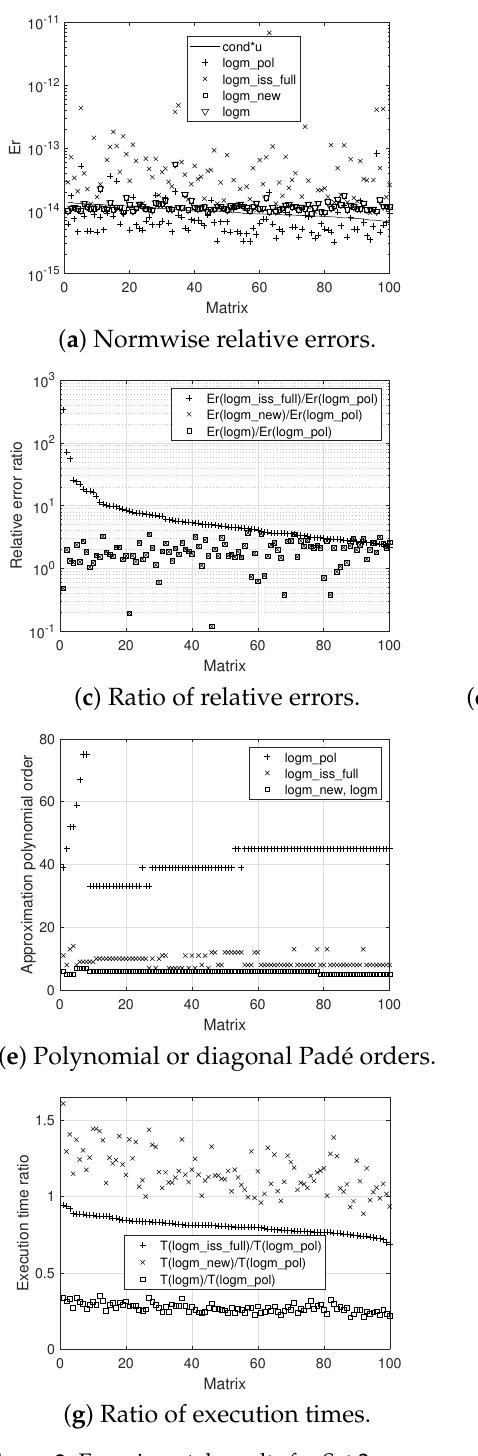
Figure 2. Experimental results for Set